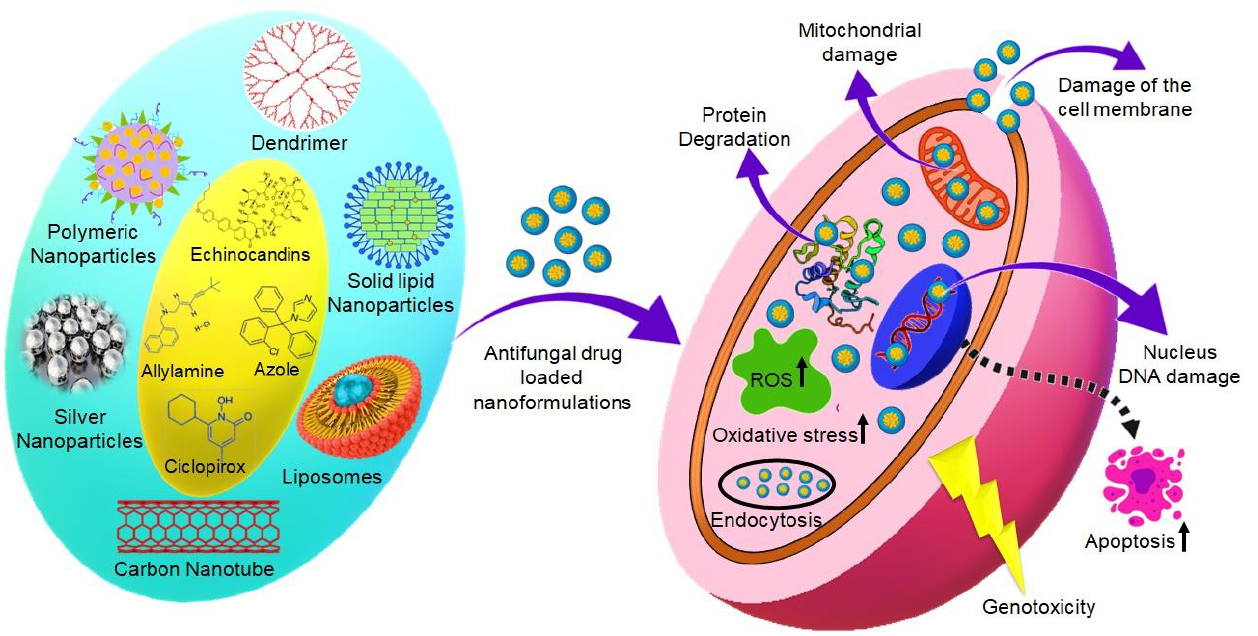
Figure 3. Schematic mechanisms of cytotoxic activity of antifungal drug-loaded nanocarriers. The cytotoxicity of chitosan NPs (ChNPs) in terms of the percentage of viable cells and percentage of cytotoxicity after their respective treatments has been analyzed. At a dose of 300 mg/mL, ChNPs killed 74.16% of the cell after 24-h incubation. The LD 50 value was obtained as 64.21 mg/mL. The inhibition rate profile of ChNPs indicated that the inhibition of cell viability was found to be dose-dependent [56].